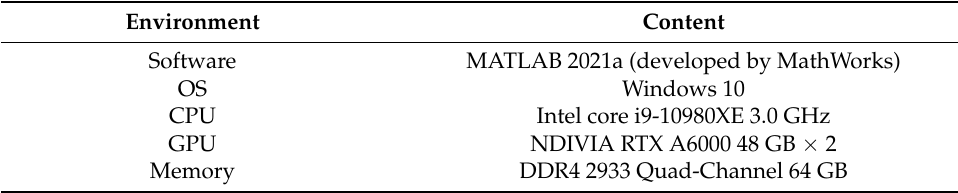
Table 2. Age estimation model. Table 3. Software/equipment used in the